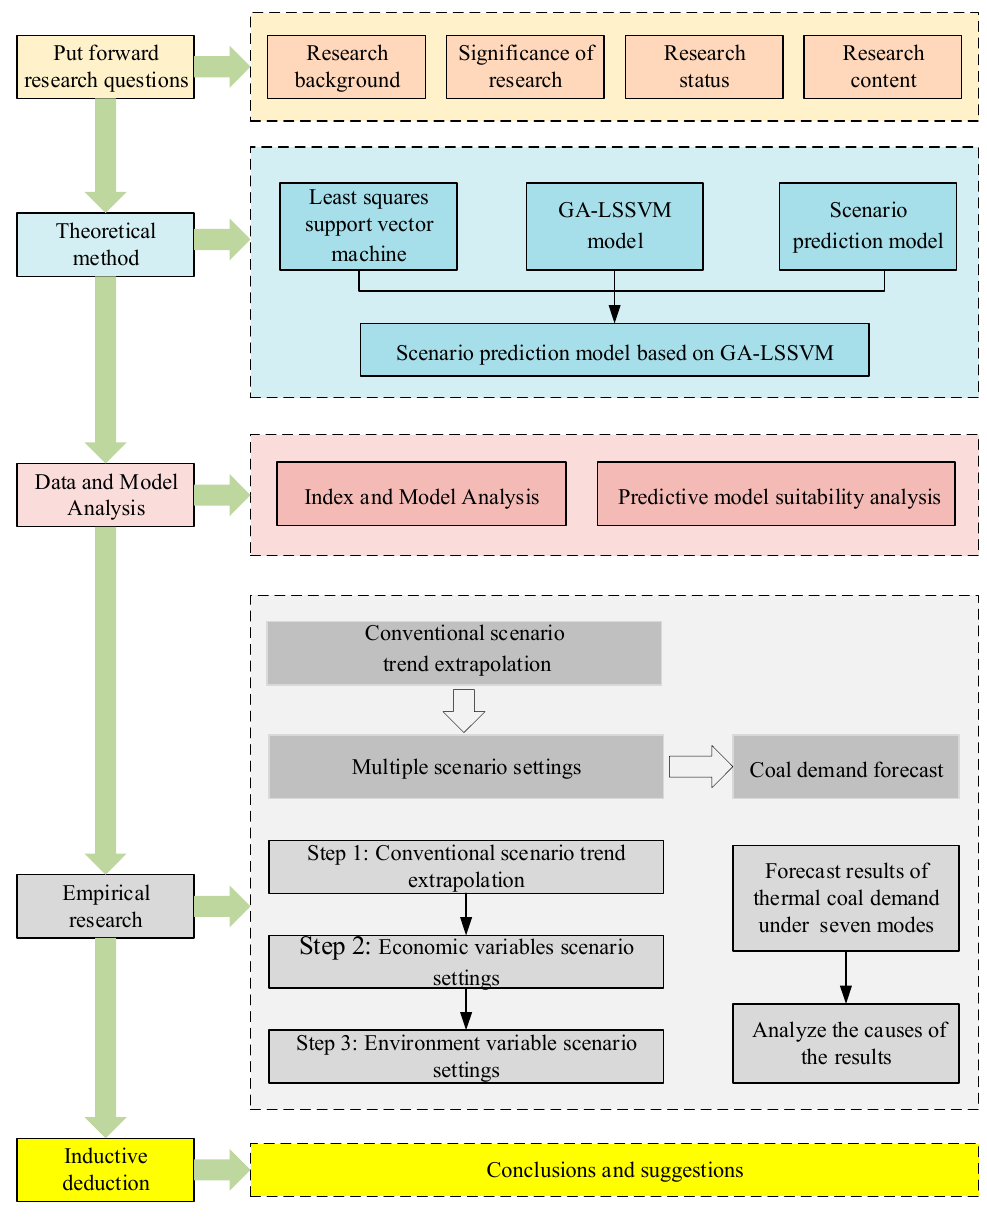
Figure 1. The structure of the paper.